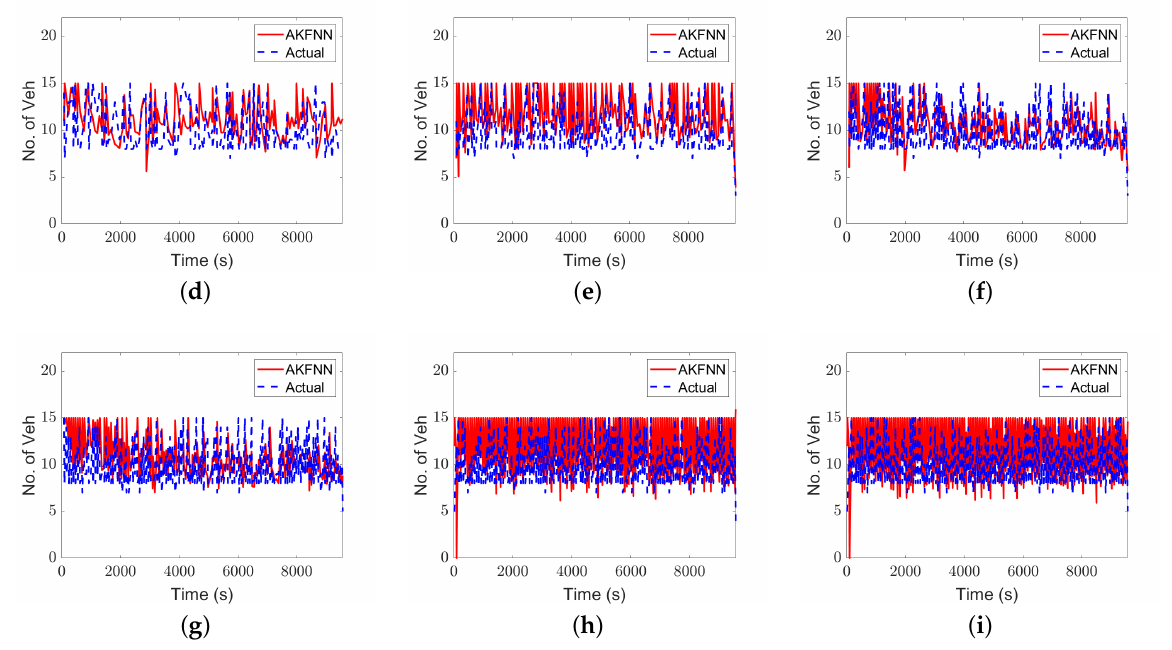
Figure 5. Actual and estimated vehicle counts over estimation intervals for different LMP scenarios: ( a ) 10%, ( b ) 20%, ( c ) 30%, ( d ) 40%, ( e ) 50%, ( f ) 60%, ( g ) 70%, ( h ) 80%, and ( i ) 90%